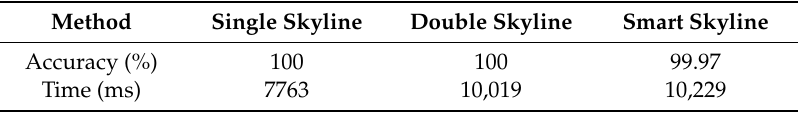
Table 23. SKY–SVM on the synthetic Dataset